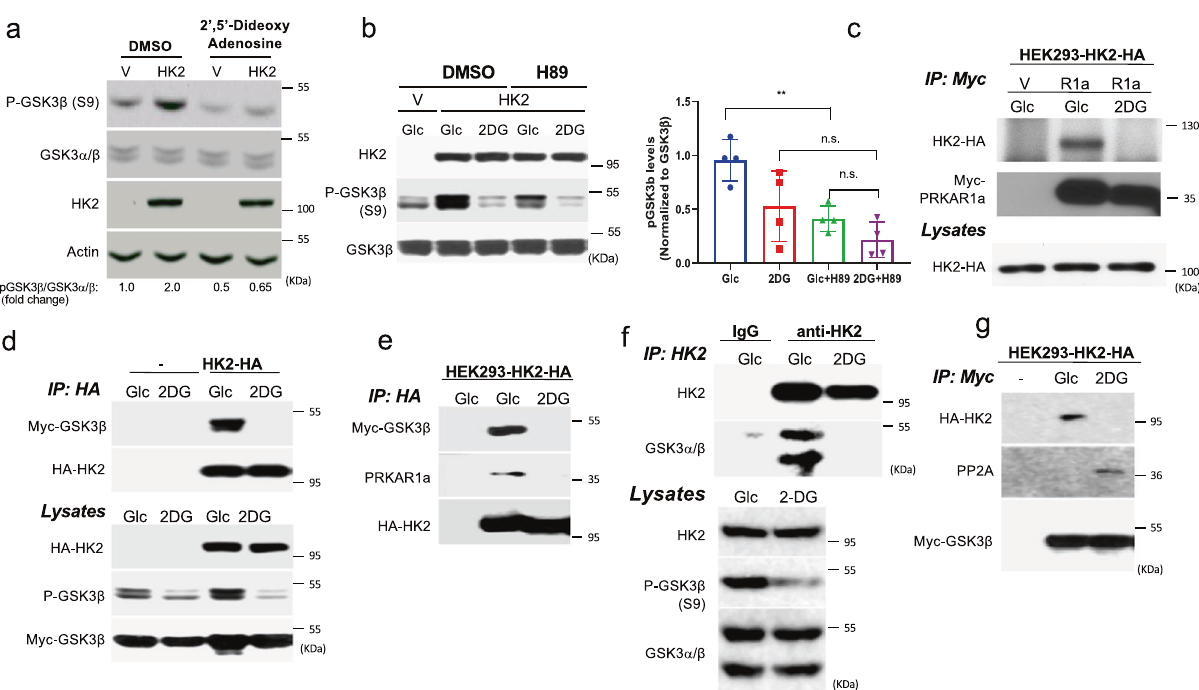
Fig. 2 HK2 affects GSK3 β phosphorylation in a PKA-dependent manner and interacts with PRKAR1a and GSK3 β in a 2-DG-dependent manner. a Immunoblot showing GSK3 β phosphorylation following HK2 expression in MI5-4 cells in the presence of the adenylate cyclase inhibitor 2 ’ 5 ’ - dideoxyadenosine 200 µ M for 6 h. Similar results obtained in two independent experiments. b GSK3 β phosphorylation following HK2 expression in MI5-4 cells in the presence of the PKA inhibitor H89. Cells were pretreated with either DMSO or H89 (10 µ M) for 2 h and then exposed to 10 mM glucose